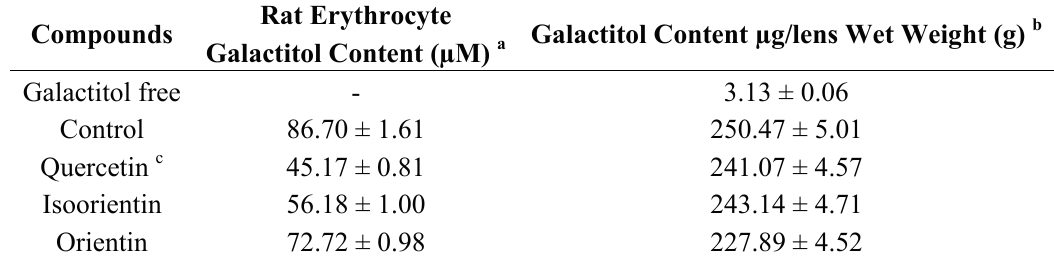
Table 3. Inhibitory effect of the constituents on the galactitol accumulation in rat lenses and erythrocyte.